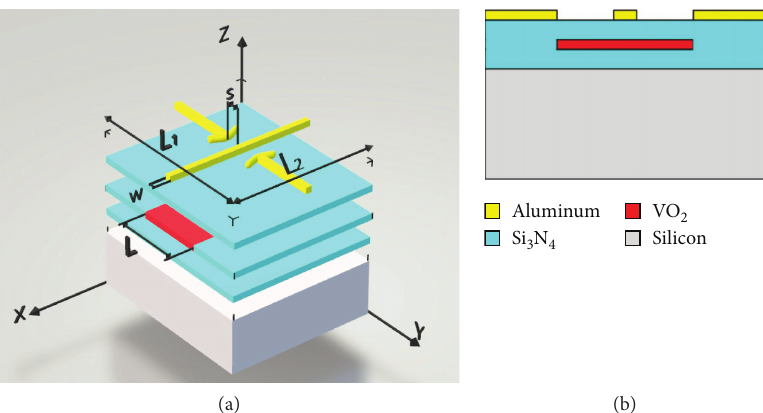
Figure 1: (a) Three-dimensional schematic diagram of the unit structure of the device. (b) Side view of the unit structure. White: silicon; blue: silicon nitride; red: VO 2 ; yellow: aluminum.